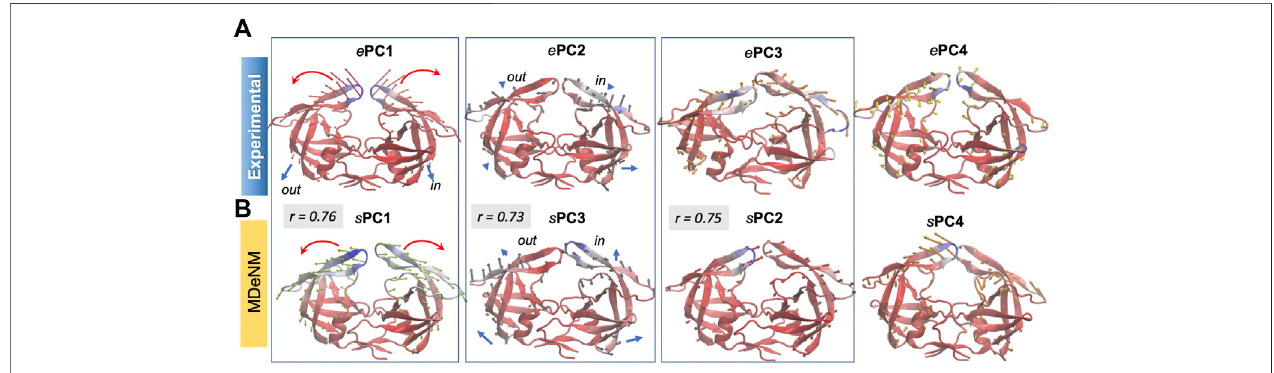
FIGURE3| First fourprincipalmodes forHIV-1PRensembles. The (A,B) arebasedonthePCAsoftheexperimental and MDeNMensembles,respectively. Those PCs that exhibit high ( > 0.70) correlations are enclosed in boxes. See the corresponding movies in Supplementary Movie S1 .